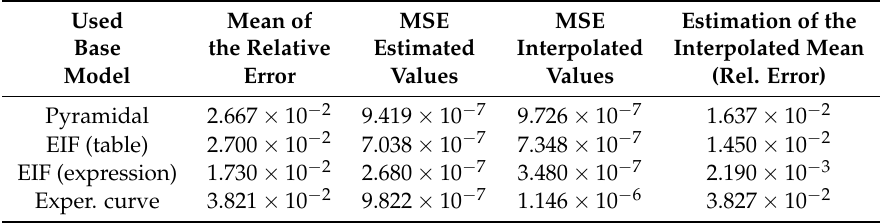
Table 4. Errors caused by the computation of the T − g syn curve. Data are generated using the pyramidal cell model and adding noise to the voltage trace derivative (mean 0 and σ V = 0.1). The errors shown in the table correspond to the difference between the original synaptic trace and the estimated one (both before and after interpolating the estimated values) by using the corresponding base model. Used Mean of